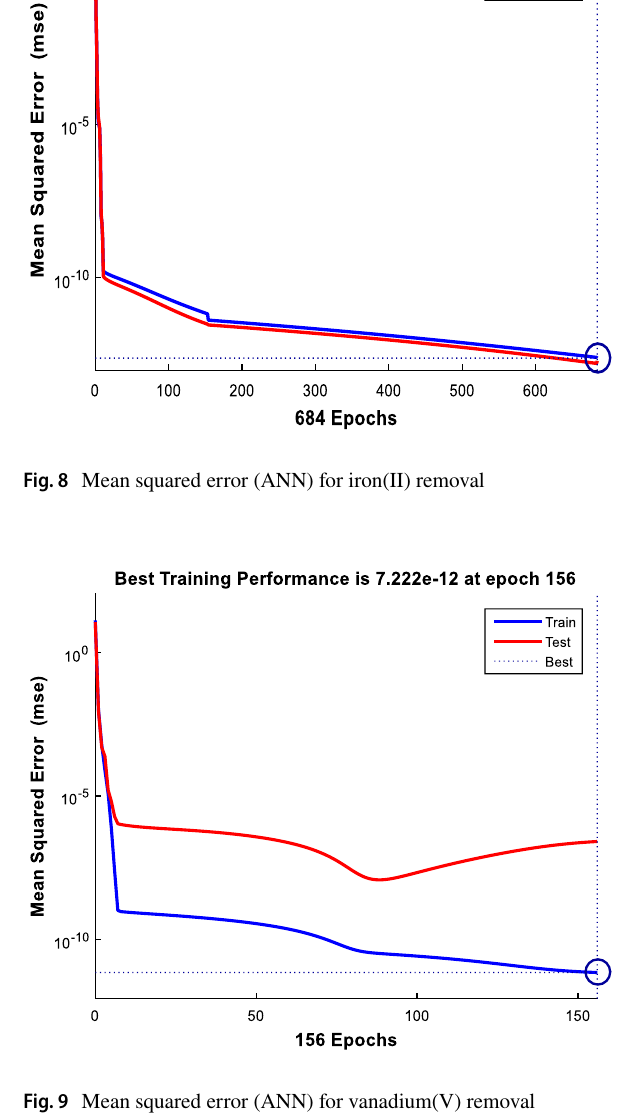
Fig. 9 Mean squared error (ANN) for vanadium(V)